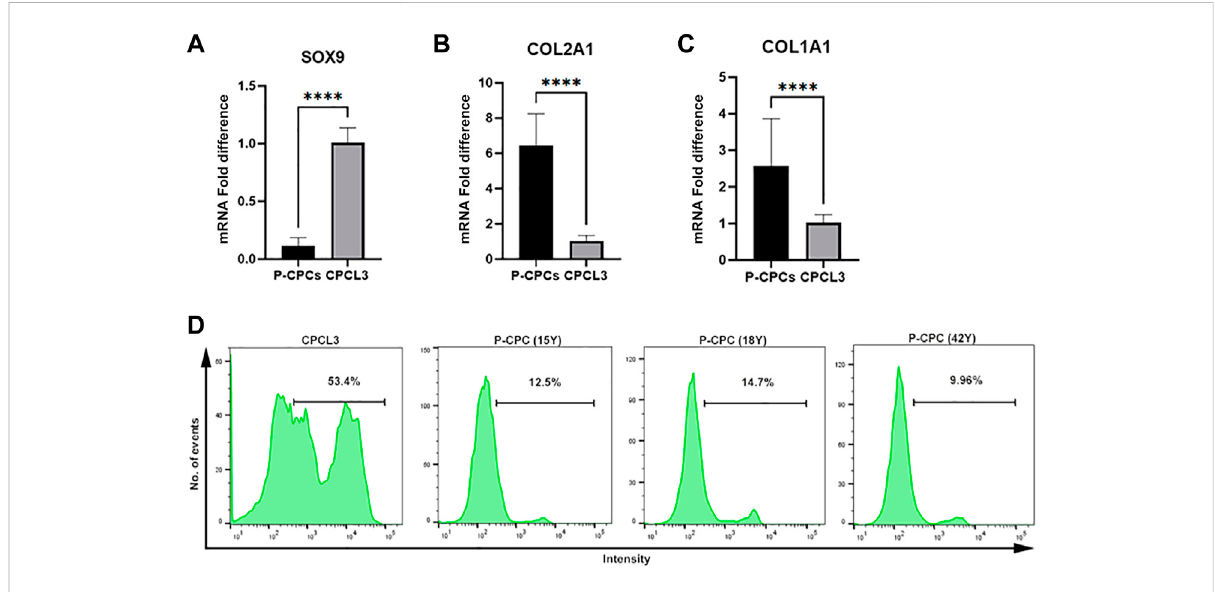
FIGURE 2 Comparison of chondrogenic marker expression and cell proliferation capacities of CPCL3 and primary CPCs. Fold differences in the mRNA expression of (A) SOX9 , (B) type 2 collagen ( COL2A1 ), and (C) type 1 collagen ( COL1A1 ) between primary CPCs and the stable CPC line, CPCL3. N